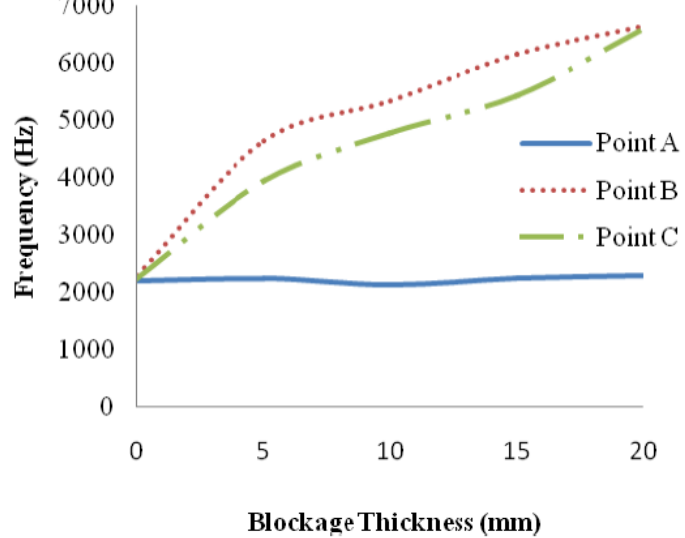
Figure 16. Frequency response at different sensor locations. Reprinted under Creative Commons CC BY license